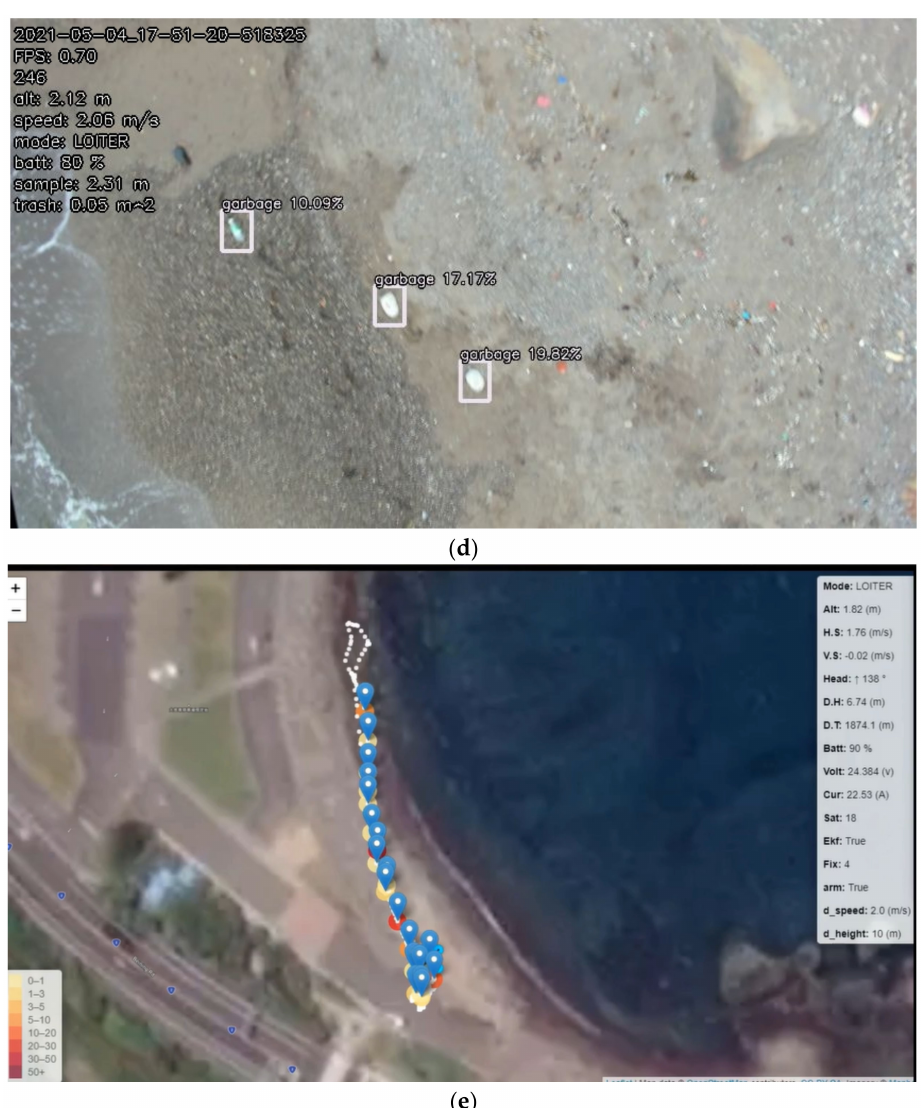
Figure 16. The result of the unmanned aerial vehicle (UAV) trash monitoring system for the Wanghai Xiang beach. ( a ) The UAV in the Wanghai Xiang beach. ( b ) Video streaming server: the detection result of a small area in the Wanghai Xiang beach. ( c ) Video streaming server: the detection result of a small area in the Wanghai Xiang beach. ( d ) Video streaming server: the detection result (a small area) in the Wanghai Xiang beach. ( e ) A UAV map to monitor the trash detection and the trash polluted area in the Wanghai Xiang